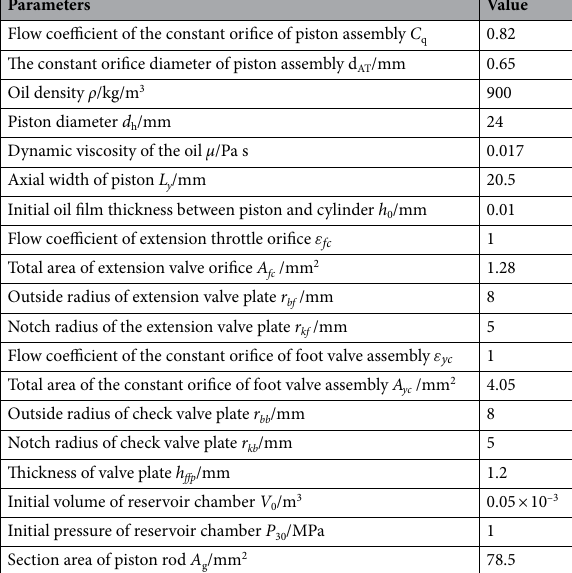
Table 1. Parameters of numerical simulation.